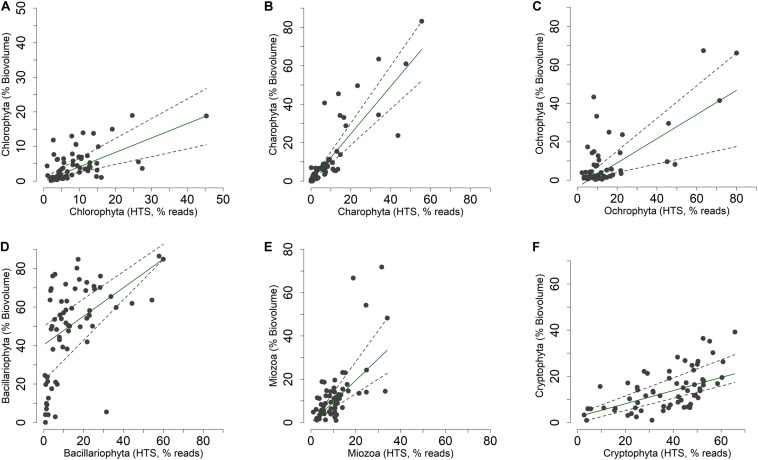
(A–F) Relationship between the relative abundances of the main phytoplankton phyla (Guiry and Guiry, 2019) estimated by light microscopy (% of biovolumes on the sample totals, mm3 m–3) and HTS (% of reads on the sample totals, rarefied table). Superimposed on the plots are the 0.50 (median fit: solid dark green) and 0.30 and 0.70 (dashed gray) quantile regression lines.